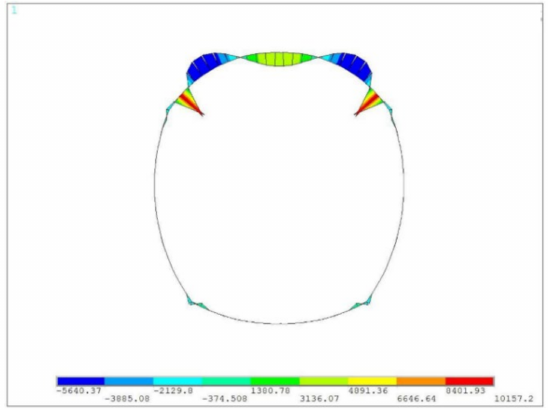
Figure 18. Bending moment diagram of supporting structure.